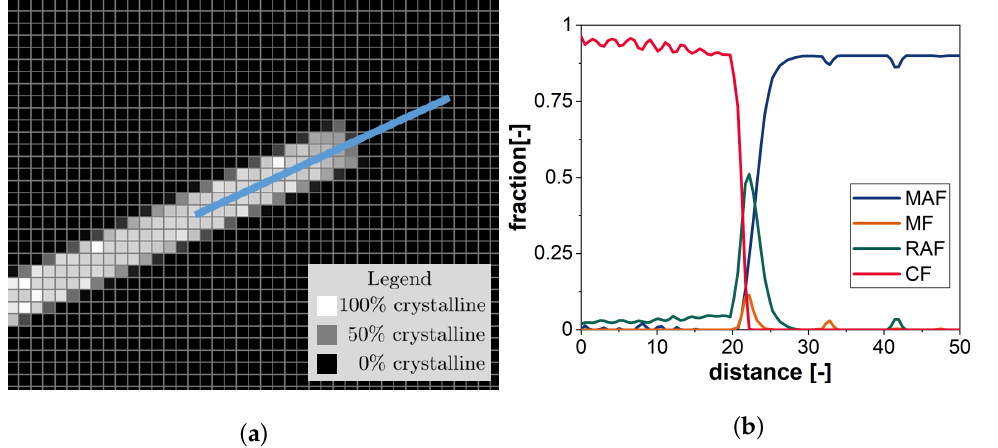
Figure 4. Simulation result for the growth of a lamella. ( a ) The crystalline phase of a lamella growing on both sides. The blue line marks the evaluation path along which the distribution of the phase fractions is evaluated in ( b